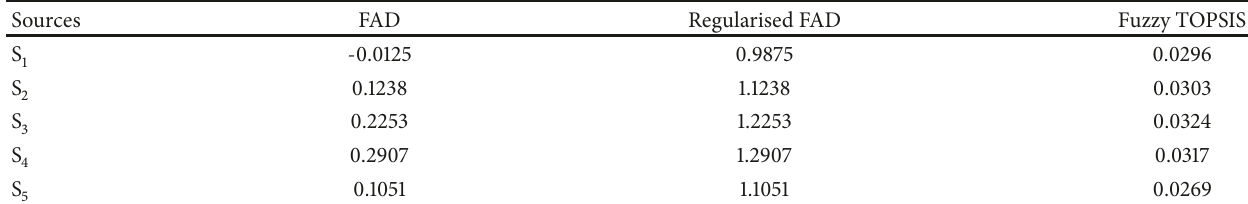
Table 20: Decision matrix for the WASPAS method.